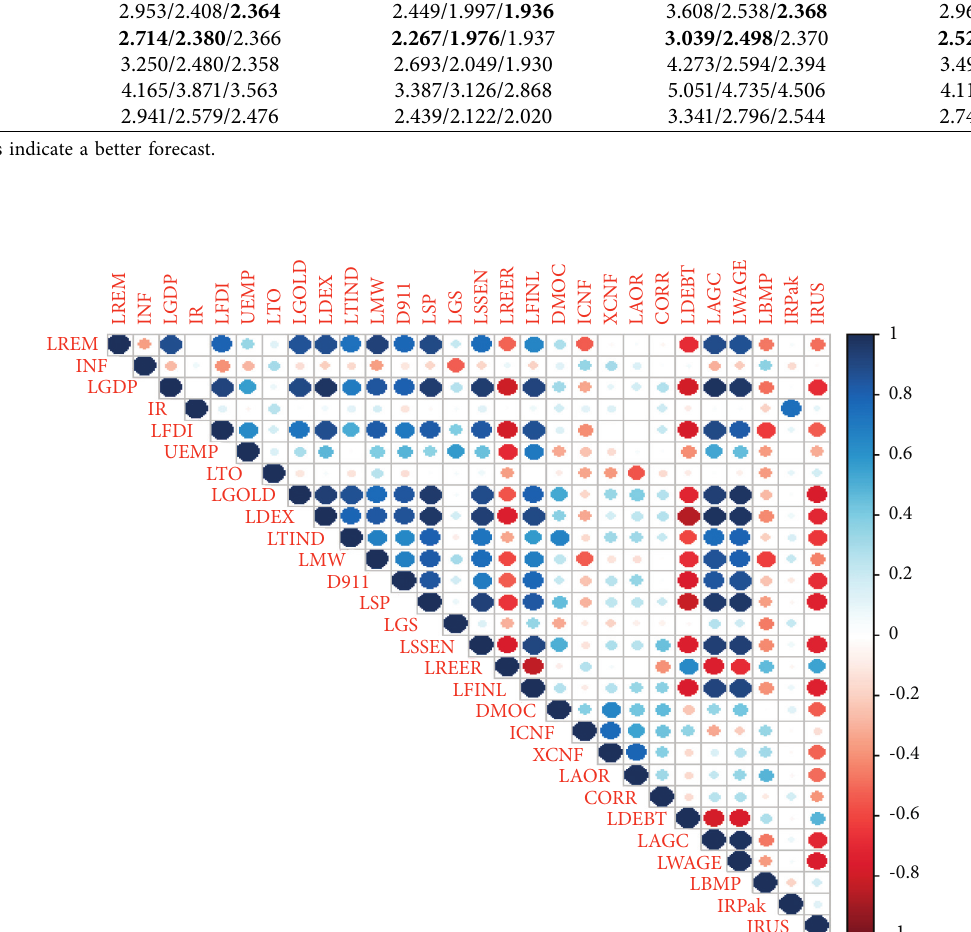
Figure 4: Pairwise correlation using macroeconomic